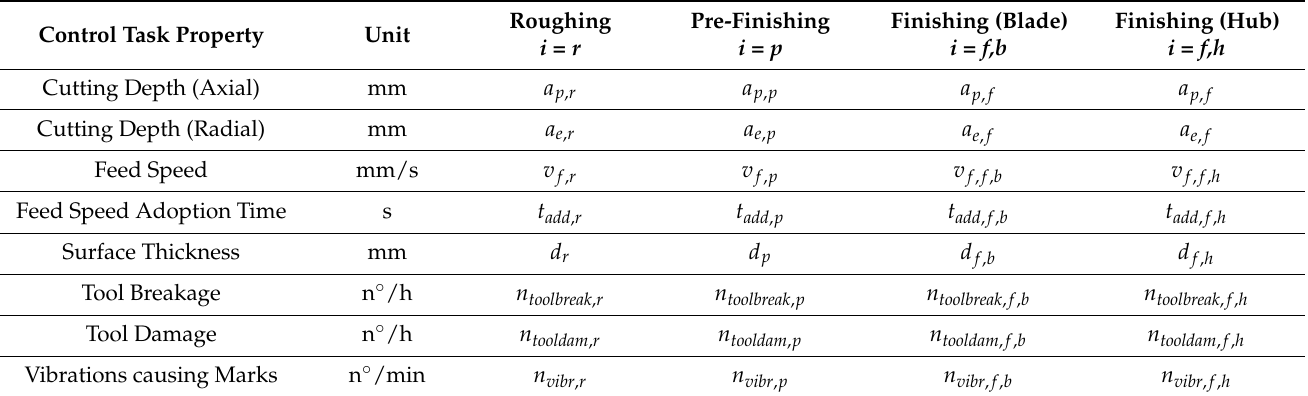
Table 6. BLISK processing control task properties being relevant for the evaluation of 5G deployment and their formula